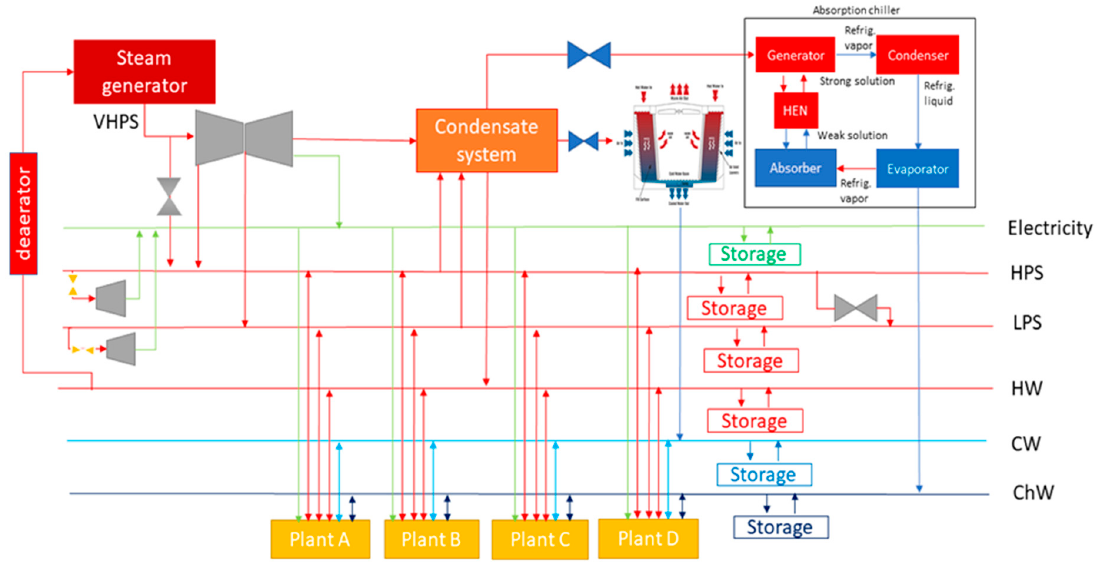
Figure 2. Schematic of a power, heating and cooling system for a Total Site.